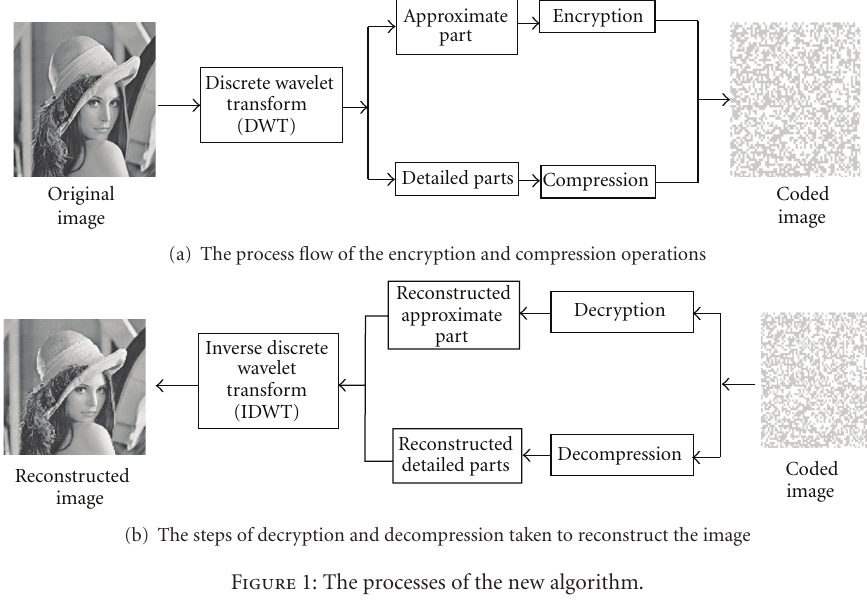
Figure 1: The processes of the new